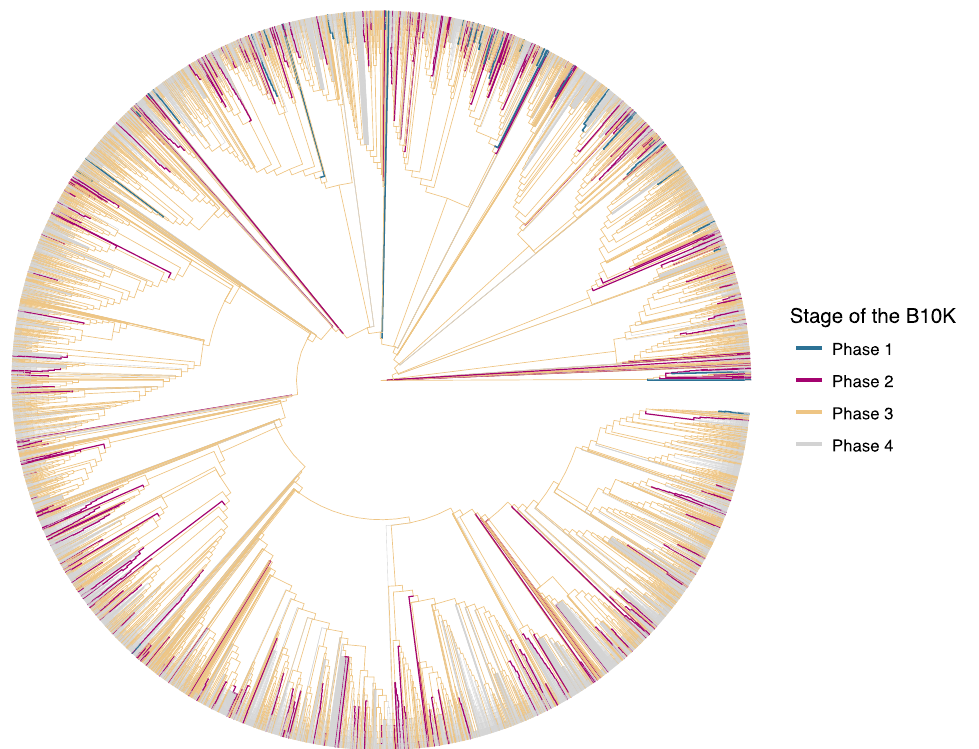
Figure 1. Overview of genomes available and in preparation for all 10,135 species of birds. We use the organization of the B10K into four successive phases to show the increasing density of genome-enabled species across the phylogeny of birds. Each phase aims to cover more fine scale relationships among bird taxa: Phase 1 sequenced 48 species from most orders (branches highlighted in blue), phase 2 includes 363 birds from most families (red), phase 3 is planning to sequence 2250 birds from all genera (yellow), and eventually all species will have genomes upon completion of phase 4 (grey). About 60% of bird species are Passeriformes and hence sampling will proportionally increase in this group starting from phase 2. The shown tree is a ‘synthetic‘ phylogeny of birds that is estimated from taxonomic information and previous phylogenetic studies [31] because a complete, sequence-based bird phylogeny is not available. Subspecies were removed from the tree and species names were matched to the taxonomy of Howard & Moore 4th edition